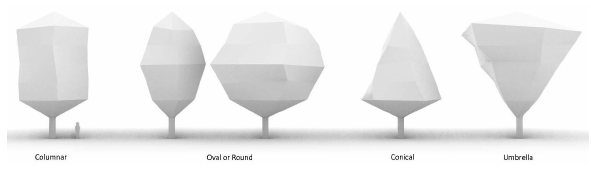
Figure 4. Combining the spatial parameters allow for a majority of crown shapes to be represented.